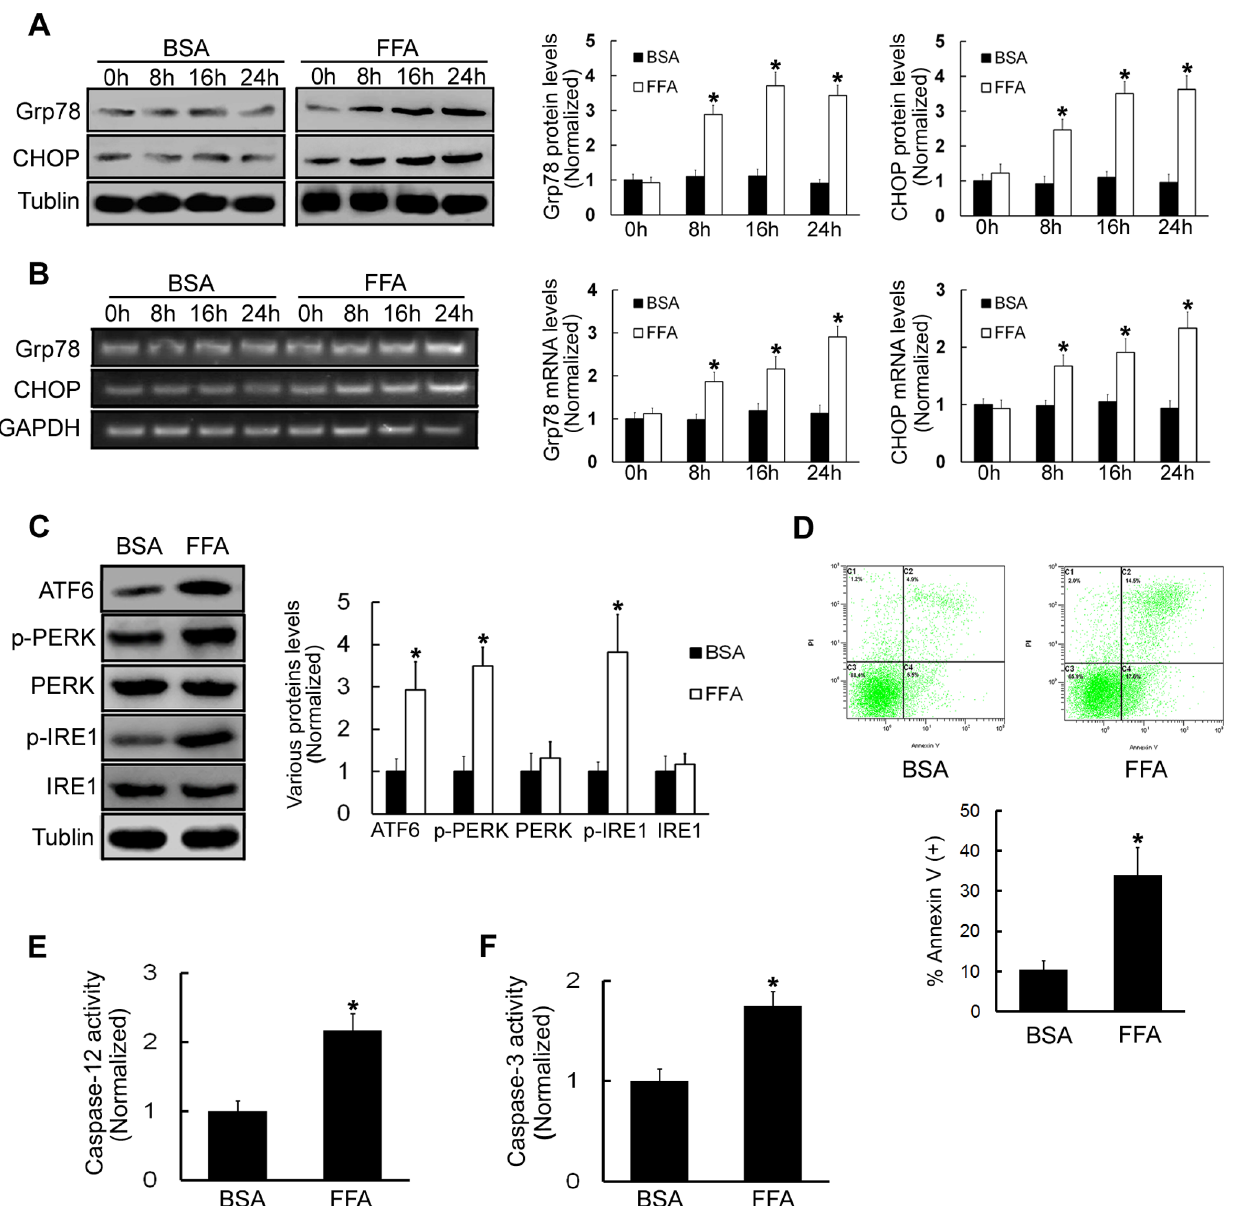
Figure 1. FFA treatments induce ERS in b -TC3 cells and increase cell apoptosis. (A) Cells were treated with 0.5 mM FFA or BSA for 0, 8, 16, or 24 h. Western blot was used to examine Grp78 and CHOP protein levels. (B) RT-PCR was used to test Grp78 and CHOP mRNA levels. (C) Cells were treated with 0.5 mM FFA or BSA for 16 h. Western blot was used to examine the expression levels of ATF6, p-PERK, PERK, p-IRE1 and IRE1. (D) Cells were treated with 0.5 mM FFA or BSA for 16 h. Cell death was quantified by annexin V/PI double staining. (E) Caspase-12 activity was detected after cells were treated with 0.5 mM FFA or BSA for 16 h. (F) Caspase-3 activity was detected after cells were treated with 0.5 mM FFA or BSA for 16 h. BSA- treated cells were used as a negative control. Bars represent each sample performed in triplicate, and the error bars represent the standard deviations. * P , 0.05, by the Student’s t -test.